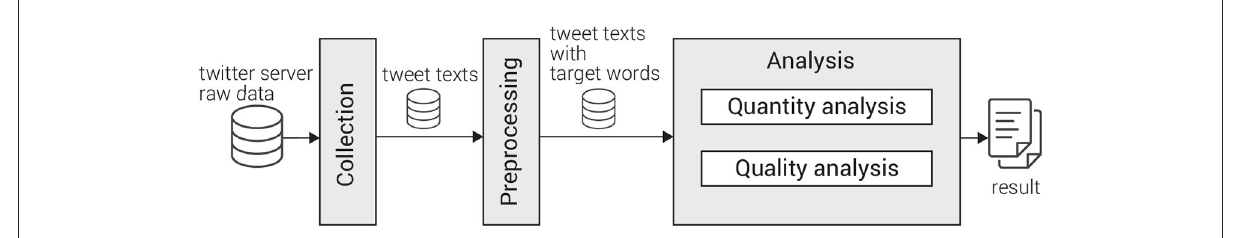
TABLE 1 Number of tweets and extracted target words. Query in Japanese Meaning in English Number of